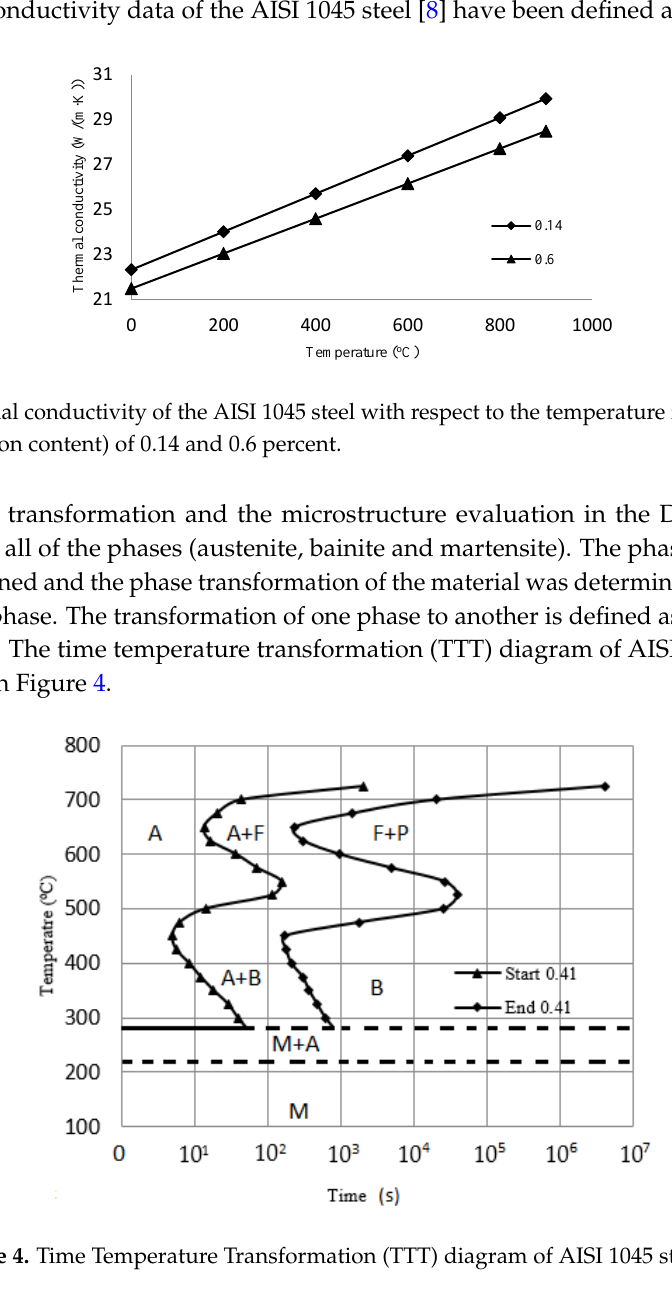
Figure 2. The flow stress and temperature as a function of effective (true) strain.